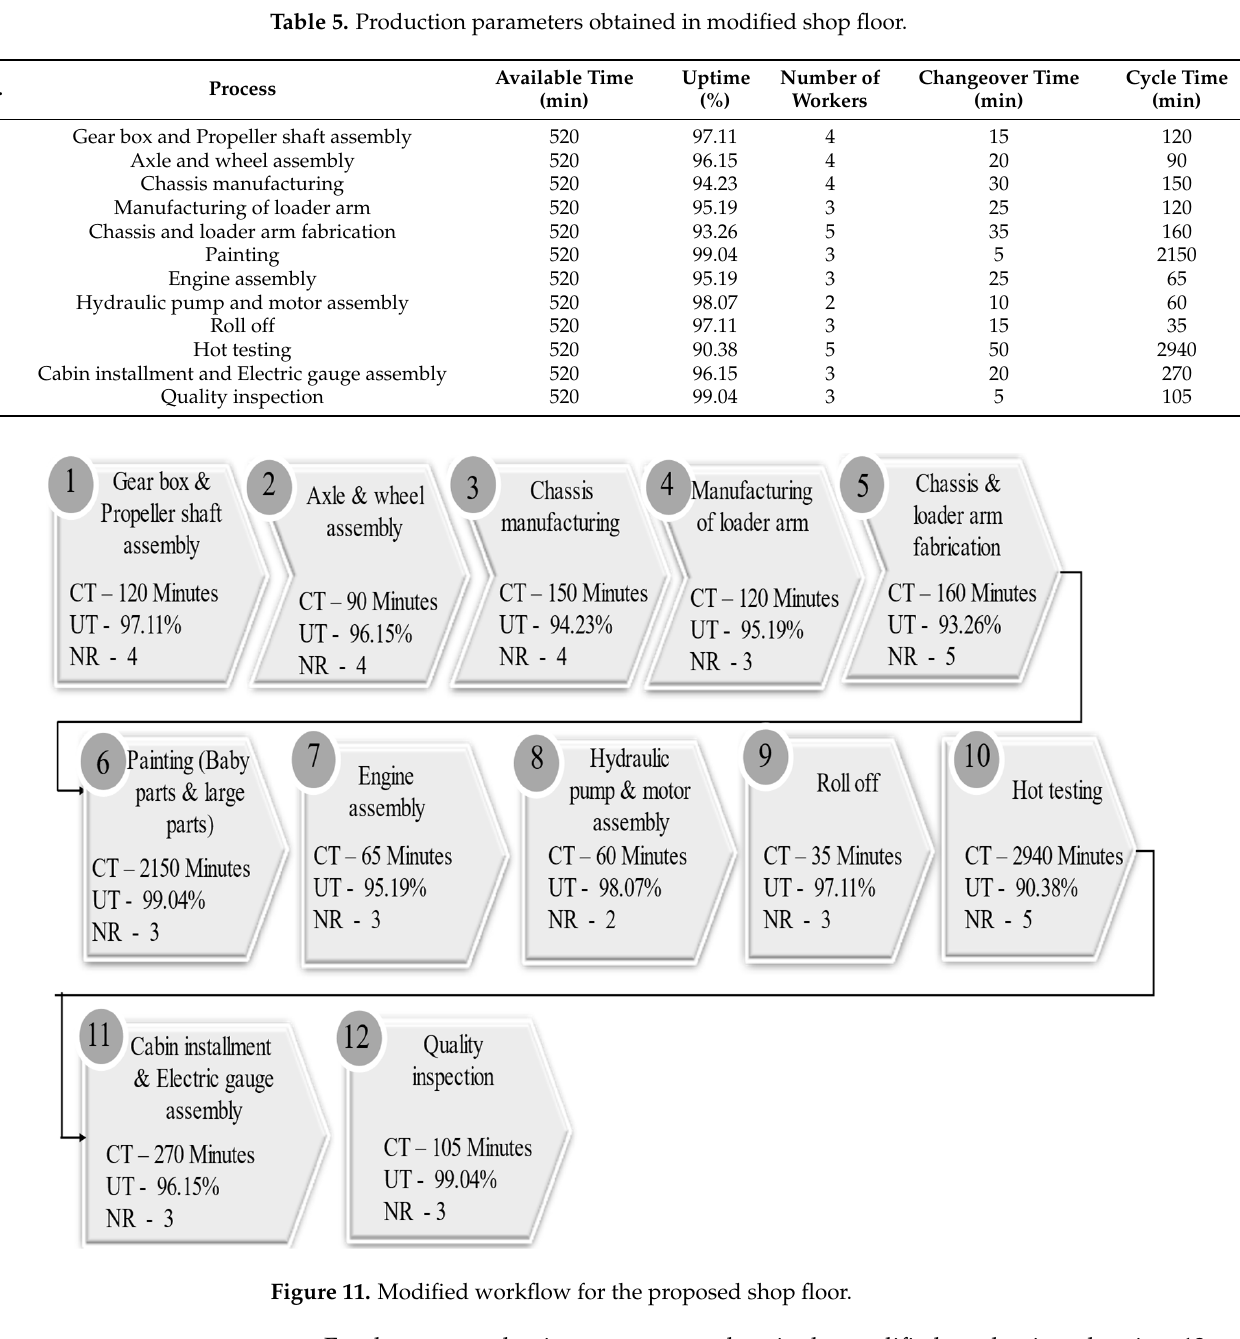
Table 5. Production parameters obtained in modified shop floor.